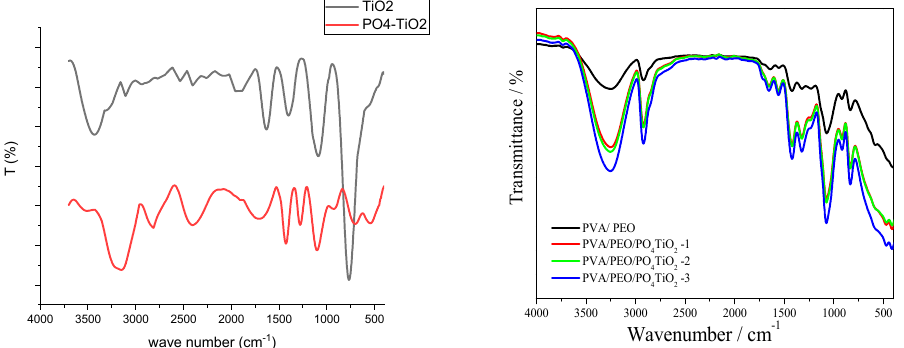
Figure 2. FTIR spectra of PO4TiO 2 ( left chart ), PVA/PEO/PO4TiO 2 membranes ( right chart ). For the membranes, the Figure 2 shows that the bands around 3250 cm − 1 refer to the characteristic stretching vibration band of hydroxyl groups on PVA and PEO. the bands at 1650 cm − 1 are attributed to the bending vibration O-H bonds. The band at 1112 cm − 1 is the characteristic band of PEO [36]. Bands at 2840 cm − 1 can be assigned to the vibration of methylene C-H bonds in the polymer’s structure. The characteristic peak for sulfate groups of sulfophithalic acid (SPA) was cited at 900 cm − 1 , while the small bands at 1700 cm − 1 indicate C=O bonds of the sulfophithalic acid (SPA), which confirms the crosslinking process. The band at 1100 cm − 1 is assigned to P-O bonds of phosphate titanium